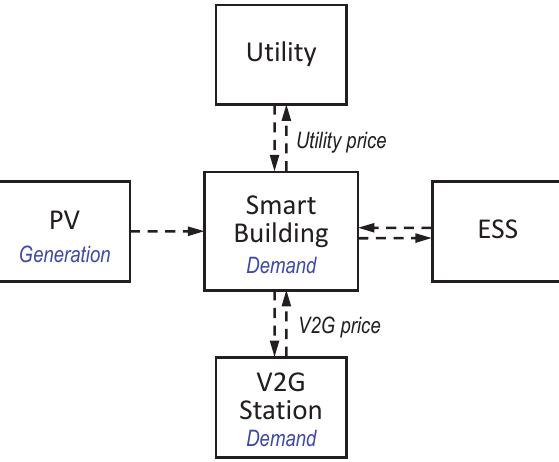
Figure 1. Illustration of smart energy building associated with utility, PV, ESS, and V2G